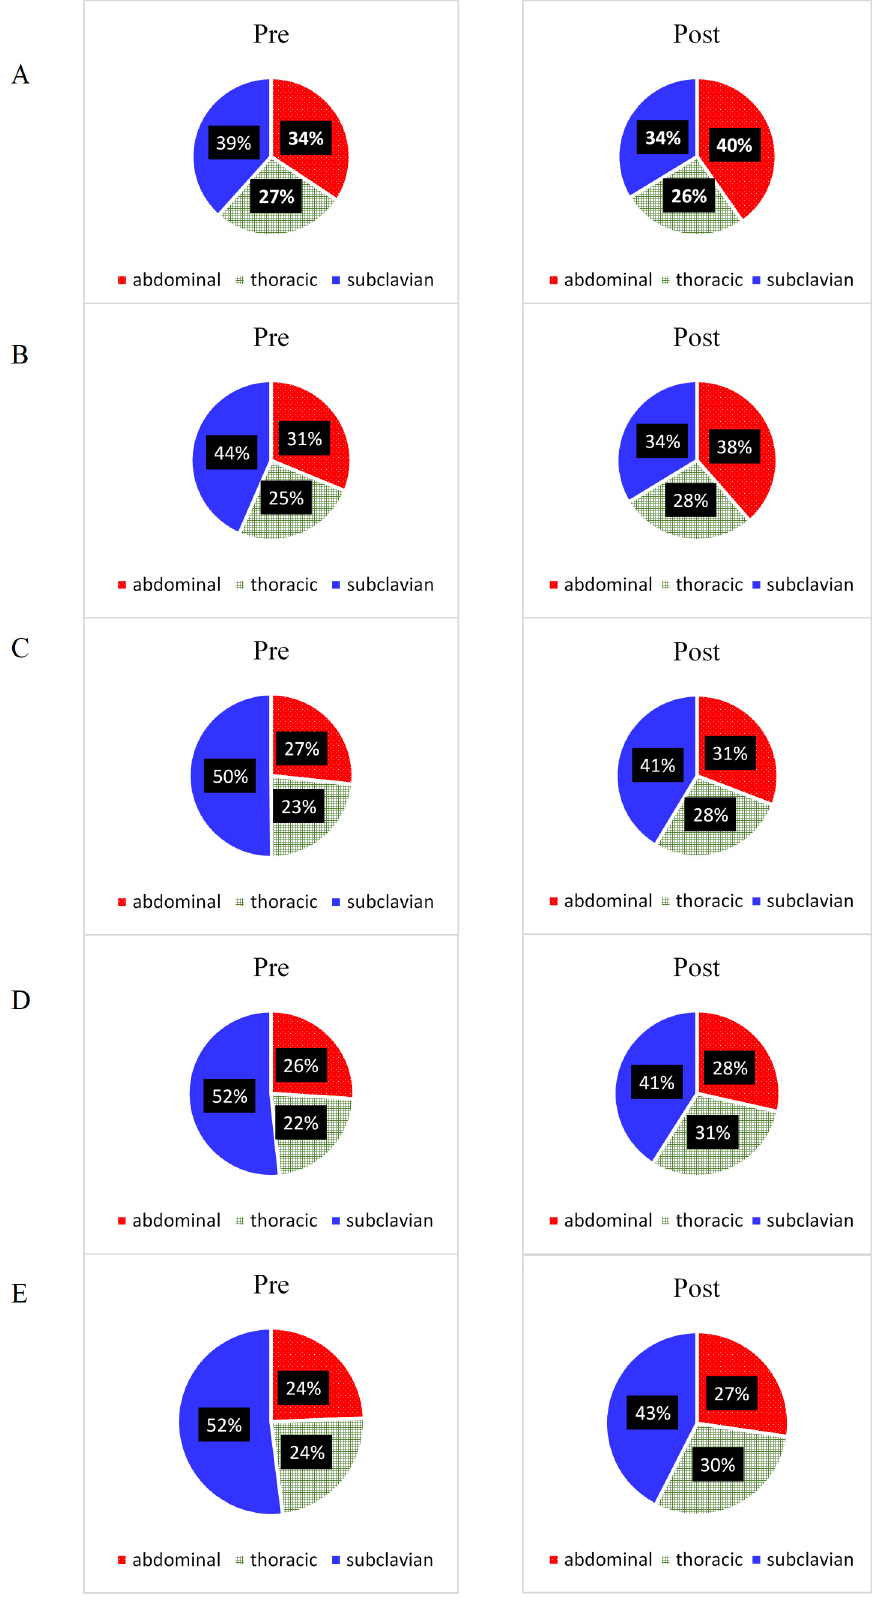
Figure 2. Engagement of breathing sectors at rest ( A ), during deep breathing ( B ), under load 2 W·kg − 1 ( C ), under load 3 W·kg − 1 ( D ), under load 4 W·kg − 1 ( E ) pre and post intervention.